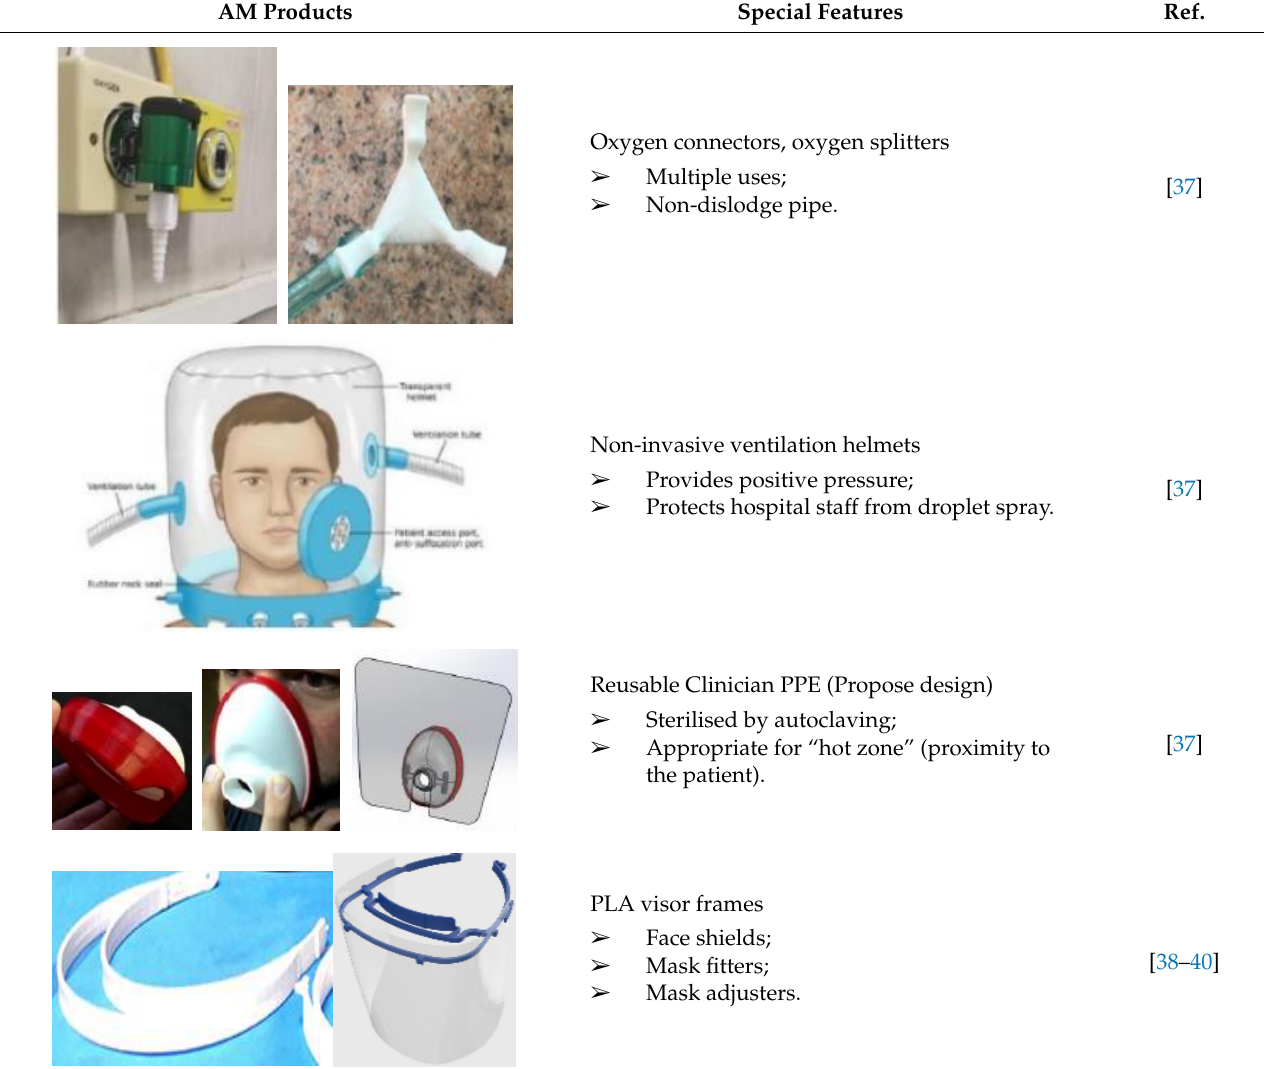
Table 1. Cont. AM